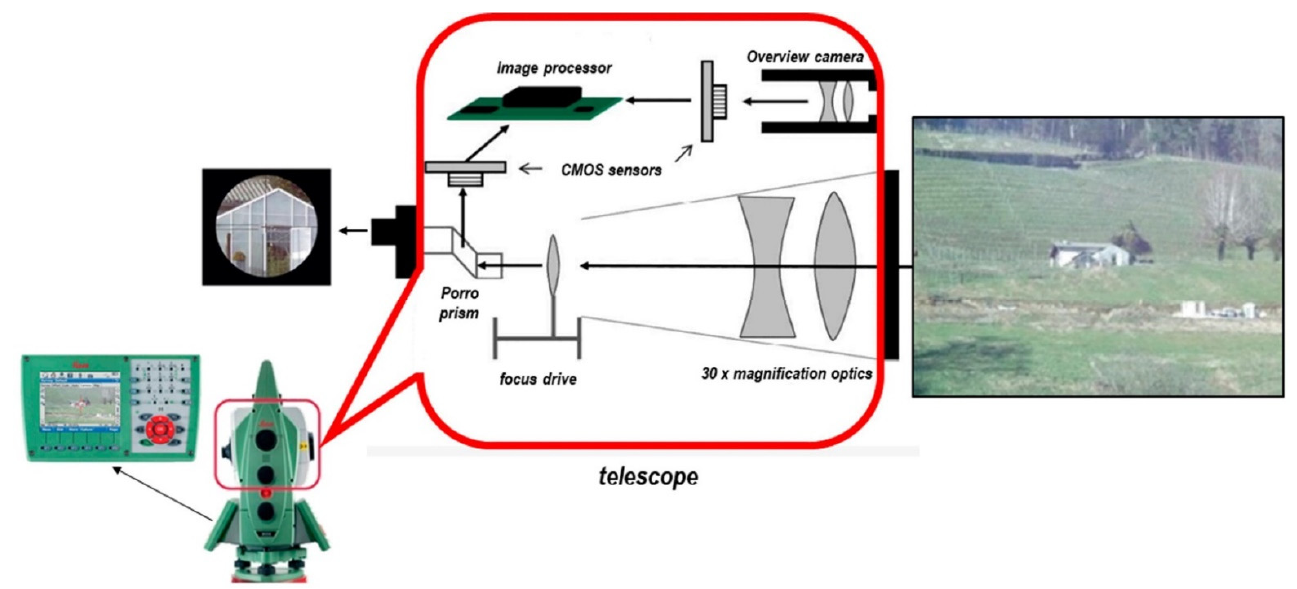
Figure 6. The image-assisted total station schematic cross-sectional view of the telescope with image sensors and processor integration, as well as motorization for autofocus; scheme modified for this study from